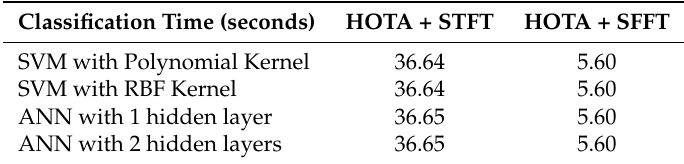
Table 4. Time used by the diagnostic system generated by the supra-system to classify the IM condition (seconds).